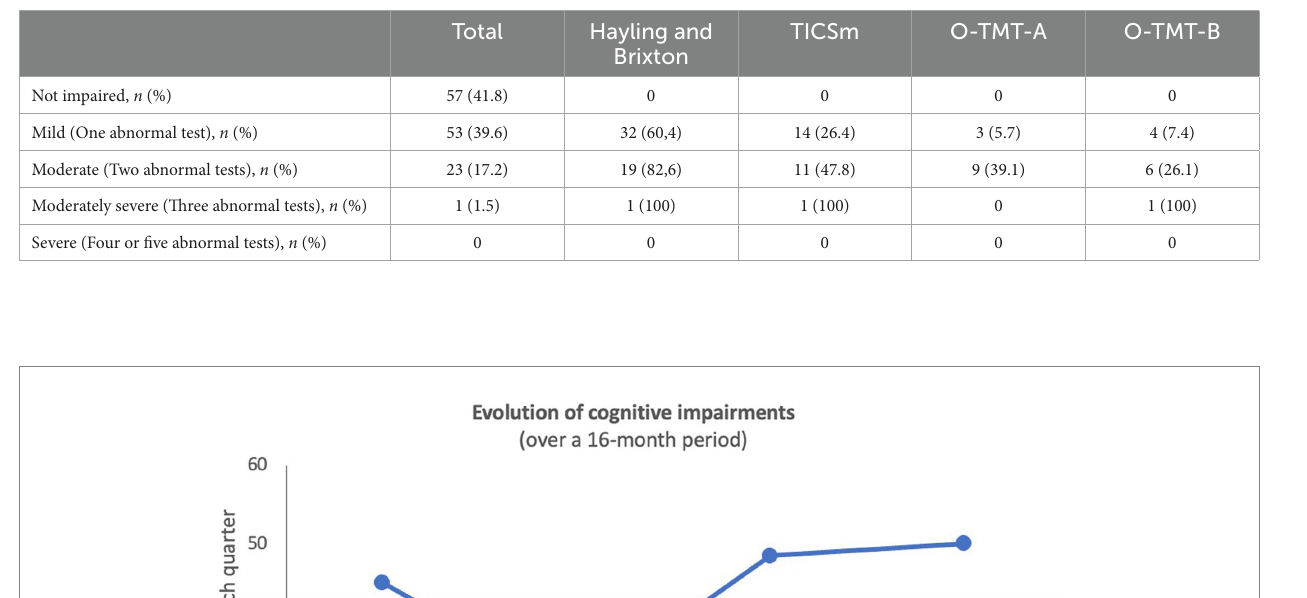
TABLE 3 The severity of cognitive impairment based on the cumulative number of abnormal tests.